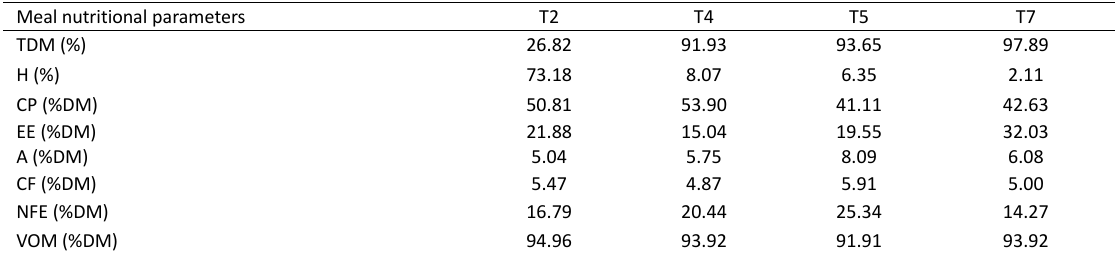
Table 5: Comparison of meal nutritional parameters according to four viable treatments (T2, T4, T5, T7) Meal nutritional parameters T2